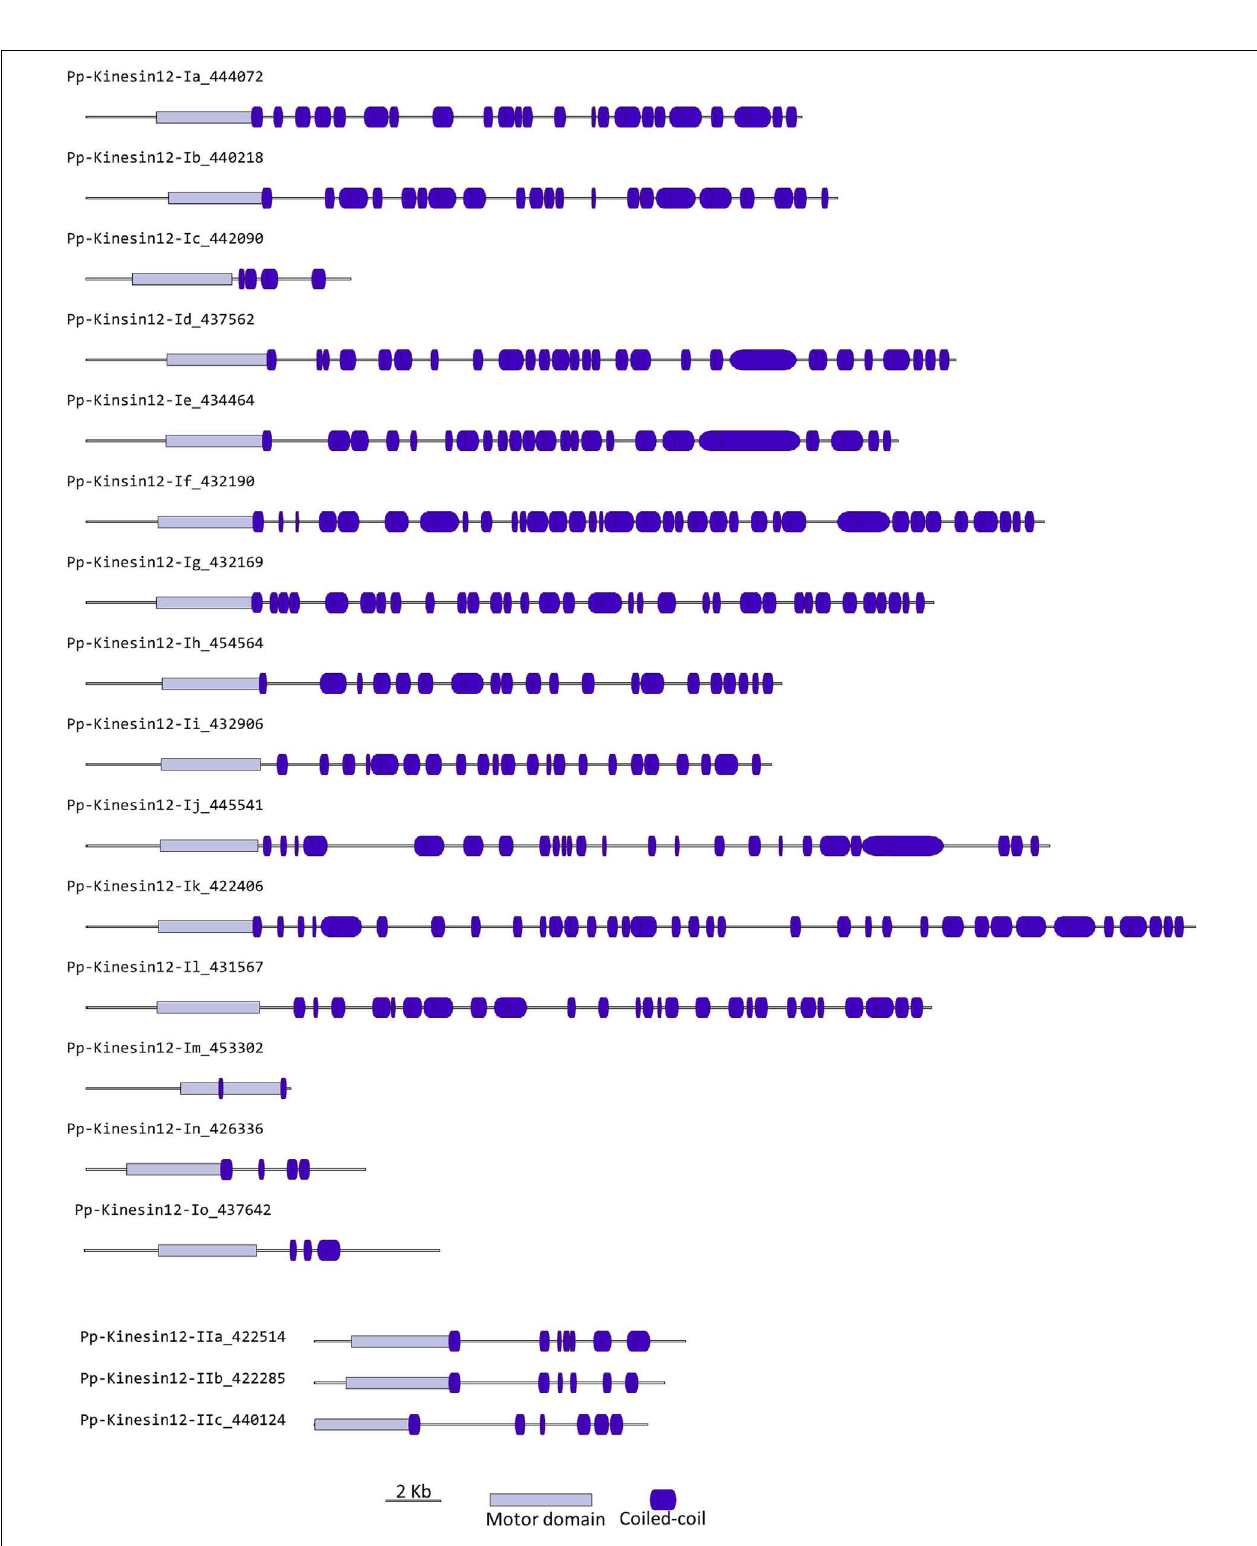
FIGURE 11 | Gene models of kinesin 12s. Schematic diagrams showing the structure and domain architecture of kinesin 12s. Domains are indicated at the bottom of the diagrams.